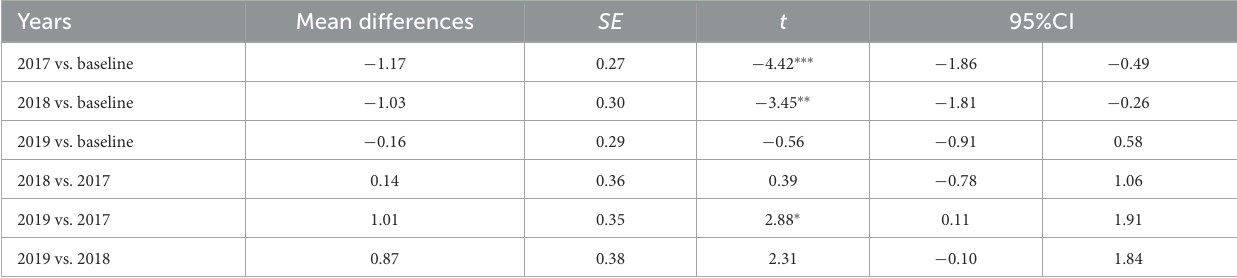
TABLE 6 Multiple comparisons: mean differences and confidence intervals for sit-and-reach across mean baseline (2013–2016), 2017, 2018, and 2019. Years Mean